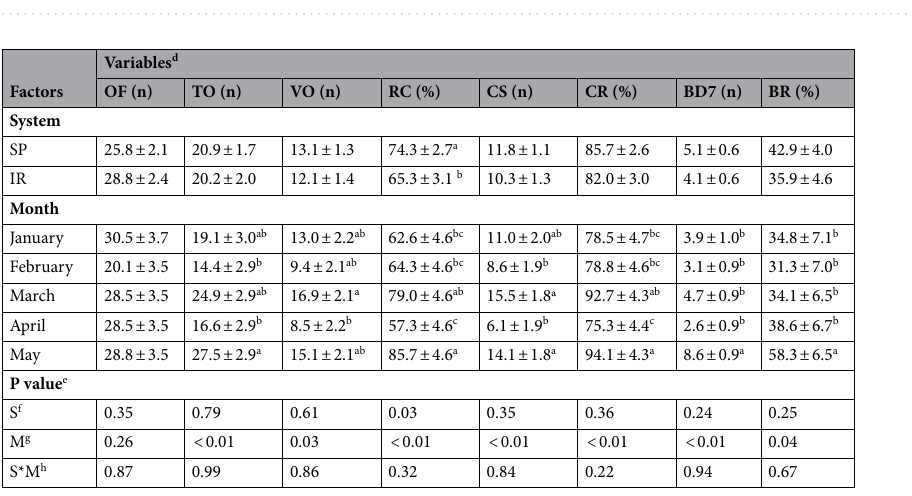
gender of calves can influence 31.4% of weaning weight 43 . Genotype and environment interactions change the weights when calves raised in SP and IR systems were compared. Despite not being a major objective of this work, more specific studies should be carried out to elucidate the effects of SP systems on calves’ performance from birth to weaning.